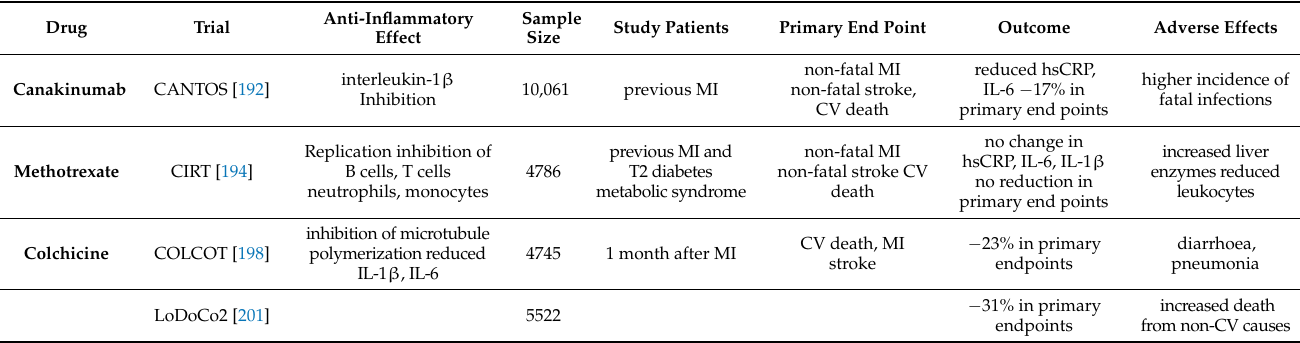
Table 2. Anti-inflammatory therapies specifically blocking cytokines